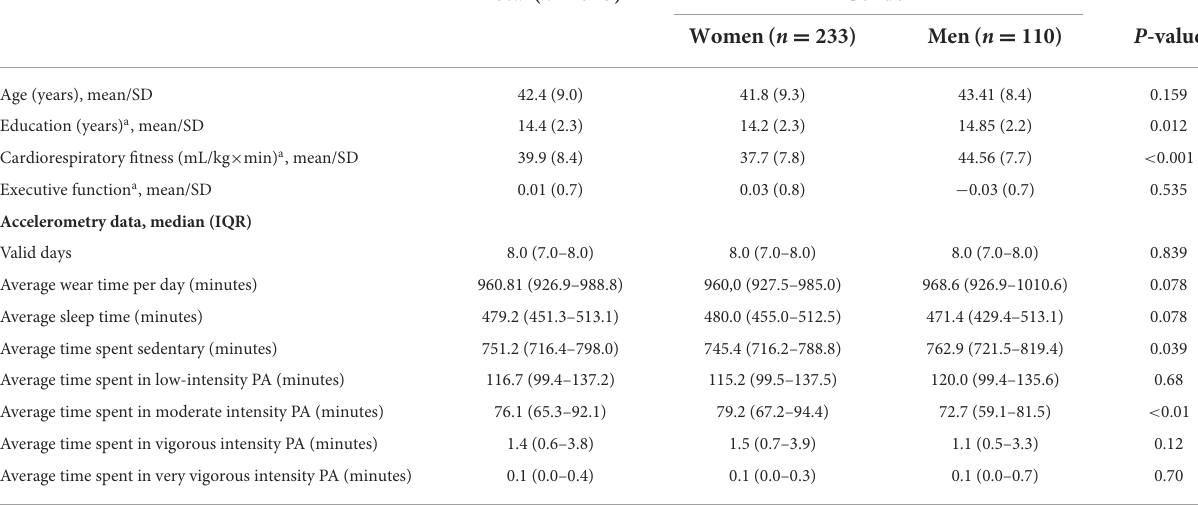
TABLE 1 Characteristics of study participants ( n =